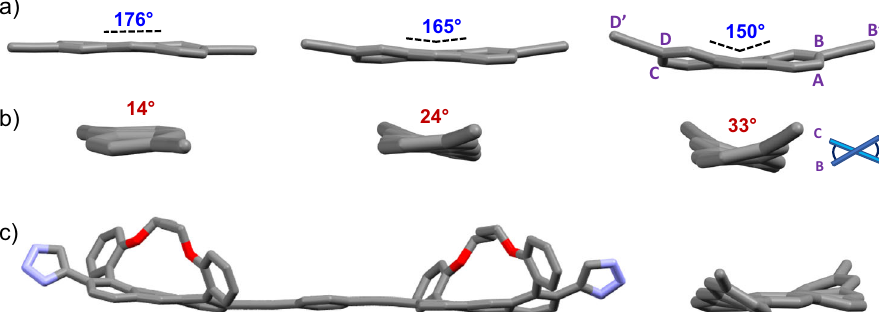
Fig. 3 X-ray analysis of twistacenes. a Side view and b end view for the X-ray structures of the anthracene cores of the monomer precursors 8-C8 (top), 8-C6 (middle), and 8-C4 (bottom), with the substituents and Cn tether removed for clarity. The bend angles between B ’ B and D ’ D are depicted in blue, and the (calculated) dihedral angles between ABCD are depicted in red. c X-ray structure of the dimer, M , M - 2-Ant-C4 , displaying both its monomeric units in the syn conformation, with hydrogens, t Bu-acetylene, and n-octyl groups removed for clarity. Right: side view with tether removed for clarity. Color scheme: gray, C; blue, N; red,